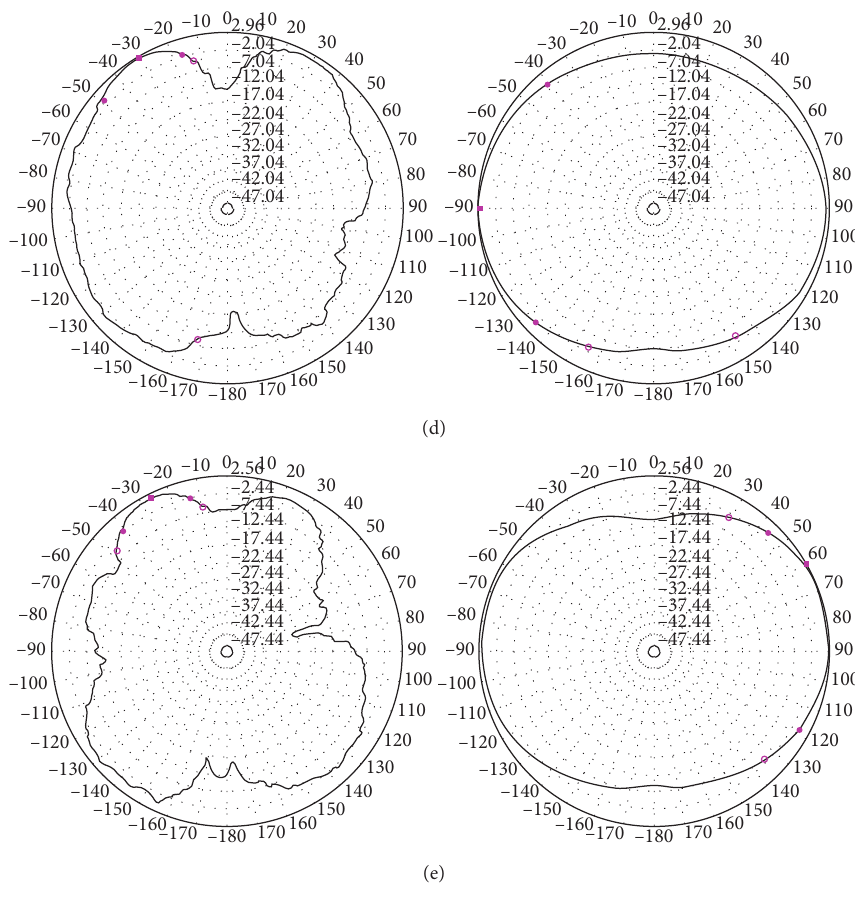
Figure 19: E/H pattern. (a) 1.45GHz,(b) 2.45 GHz, (c) 3.85GHz,(d) 5.13GHz, and (e)